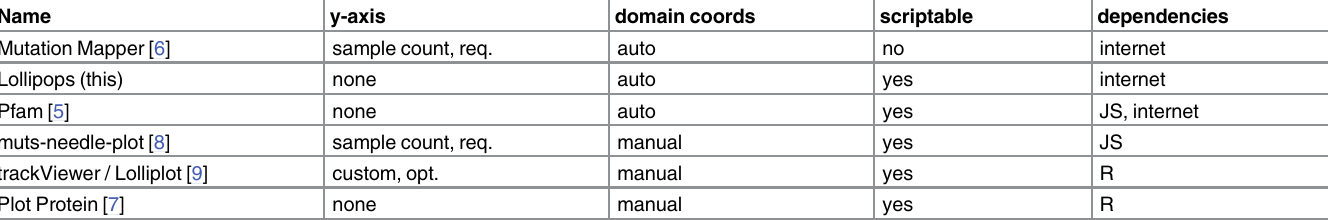
(versus automatically fetched). scriptable indicates the source code can be modi fi ed to integrate with existing tools and/or customized to fi t report styles. dependencies indicates if the tool requires anything additional to function such as internet access, a JavaScript runtime environment (JS), or the R statitistical software package